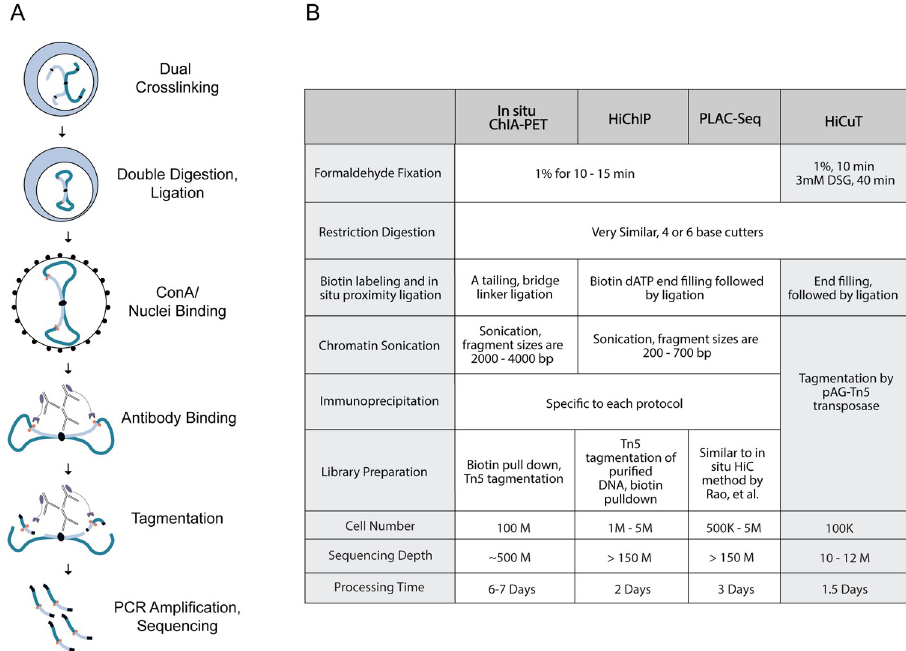
Fig 1. HiCuT identifies protein directed chromatin interactions in low cell numbers. (A) Method schematic. (B) Comparison of HiCuT protocol to existing methods.